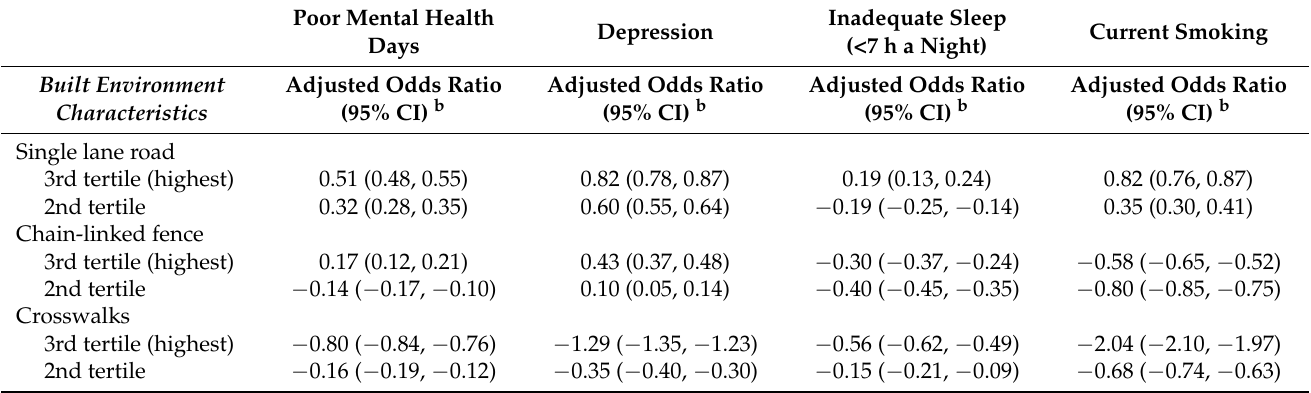
Table 3. Built environment predictors of adult mental health and risk behaviors a